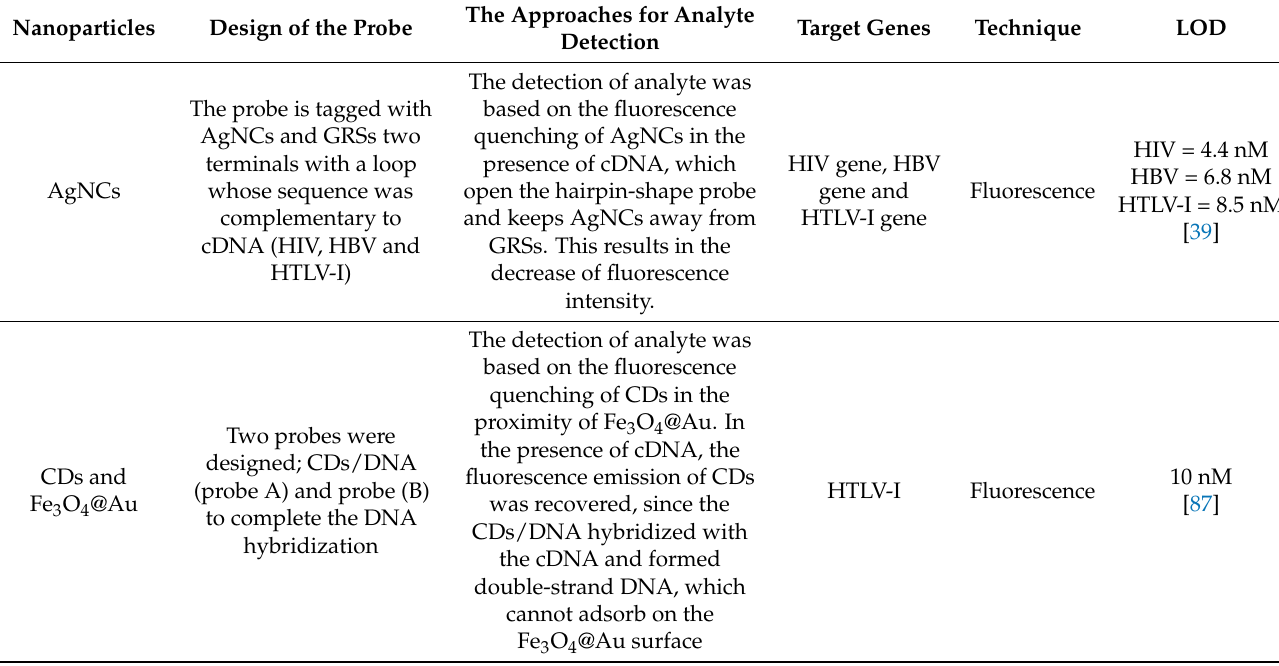
Figure 10. The schematic diagram that summarizes the development of AuNPs- or AgNPs-based biosensors. Table 1. A summary of the different types of Au and Ag nanoparticles-based biosensors used in the detection of pathogenic RNA viruses. The literature citation is indicated under the column of